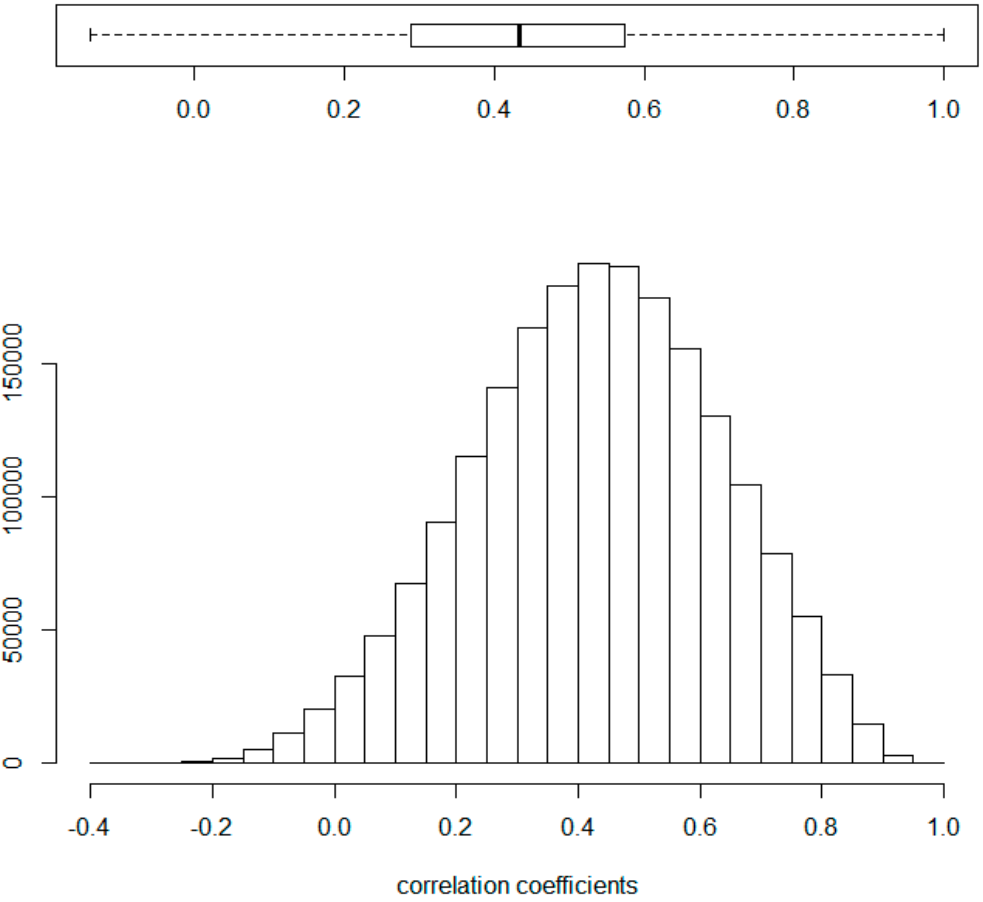
Figure 4. The histogram and boxplot of pairwise correlation coe ffi cients between 2000 expression levels of genes for the colon and normal group combined. The number of correlation coe ffi cients is 1,999,000. Two plots show that average pairwise correlation is 0.428 (median = 0.433) with a standard deviation of 0.203.